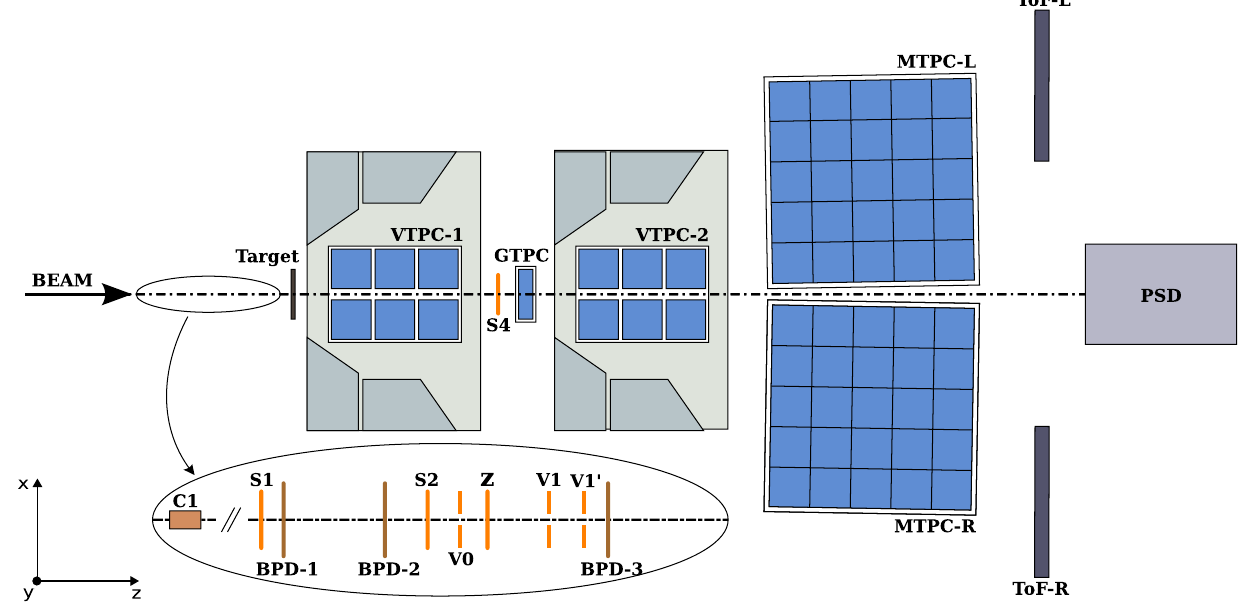
Fig. 1 The schematic layout of the NA61/SHINE experiment at the CERN SPS [13] showing the components used for the Be+Be energy scan(horizontalcut,nottoscale).Thebeaminstrumentationissketched in the inset (see also Fig. 2). Alignment of the chosen coordinate sys-